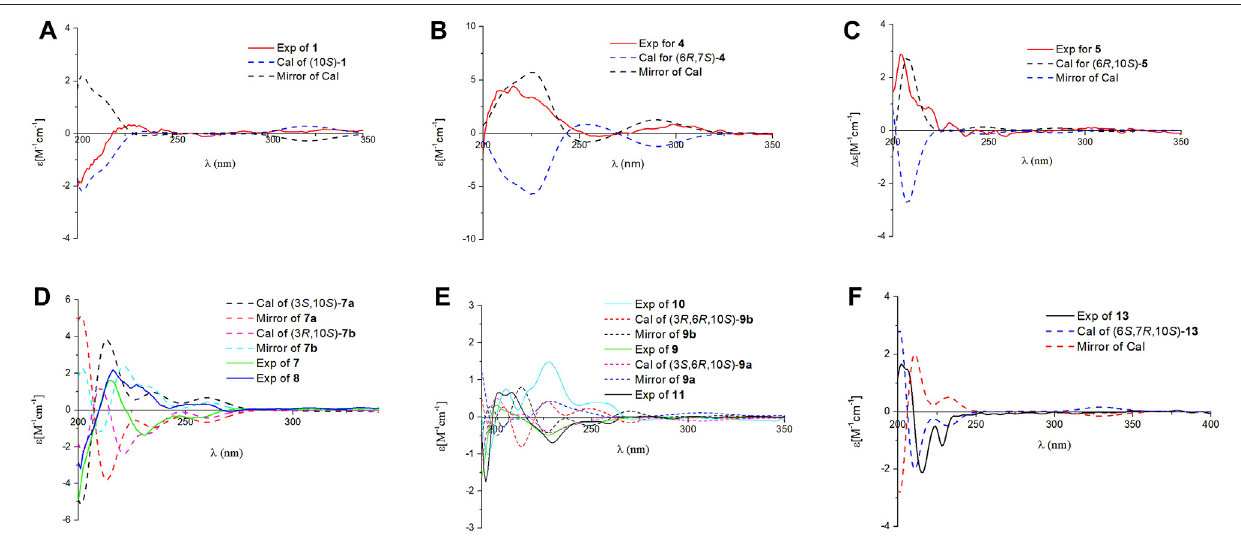
FIGURE 4 | Comparison of the calculated ECD and experimental CD spectra in MeOH. (A) : The calculated ECD spectrum of (10 S )- 1 at CAM-B3LYP/def2SVP level, σ (cid:2) 0.20 eV; shift (cid:2) – 13 nm. (B) : The calculated ECD spectrum of (6 R ,10 S )- 4 at CAM-B3LYP/def2SVP level, σ (cid:2) 0.28 eV; shift (cid:2) +8 nm. (C) : The calculated ECD spectrum of (6 R ,10 S )- 5 at B3LYP/6-31G (d,p) level, σ (cid:2) 0.25 eV; shift (cid:2) +20 nm. (D) : The calculated ECD spectrum of (3 S ,10 S )- 7a at B3LYP/6-31G (d,p) level, σ (cid:2) 0.25 eV;shift (cid:2) +20 nmandcalculatedECDspectrumof(3 R ,10 S )- 7b atB3LYP/6-31G(d,p)level, σ (cid:2) 0.23 eV;shift (cid:2) +20 nm. (E) :ThecalculatedECDspectrumof (3 S ,6 R ,10 S )- 9a at CAM-B3LYP/def2SVP level, σ (cid:2) 0.28 eV; shift (cid:2) +13 nm and calculated ECD spectrum of (3 R ,6 R ,10 S )- 9b at B3LYP/6-31G (d,p) level, σ (cid:2) 0.20 eV; shift (cid:2) +16 nm. (F) : The calculated ECD spectrum of (6 S ,6 R ,10 S )- 13 at CAM-B3LYP/def2SVP level, σ (cid:2) 0.20 eV; shift (cid:2) – 2 nm.